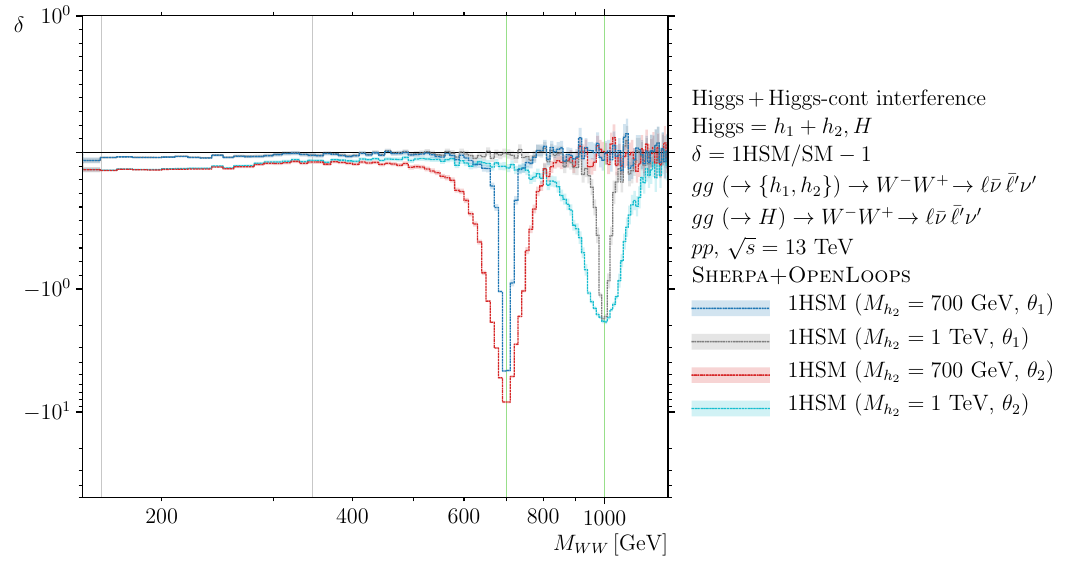
M WW distributions of the relative deviation δ = R 1 of the Higgs cross section − = 700 , 1000 GeV, θ 1 , θ 2 ) 2 { } { } ) W − W + (cid:22) ¯ ν ¯ (cid:22) (cid:30) ν (cid:30) in pp collisions at √ s = 13 TeV. h 1 , h 2 , H } → → → {